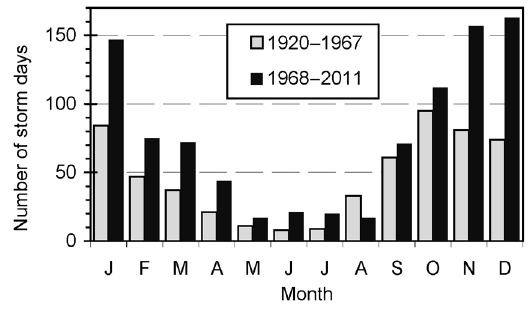
Fig. 3. Seasonal distribution of storm days at Vilsandi in two periods (considering gaps, both include data from 44 years).